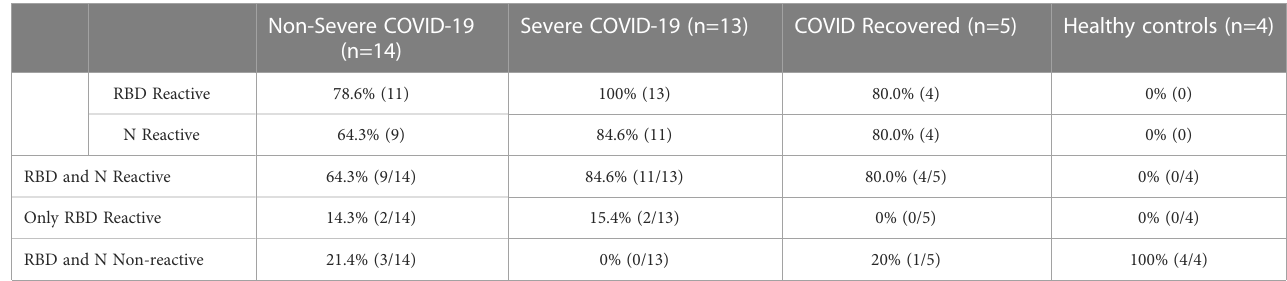
TABLE 2 SARS-CoV-2 RBD and N ELISA